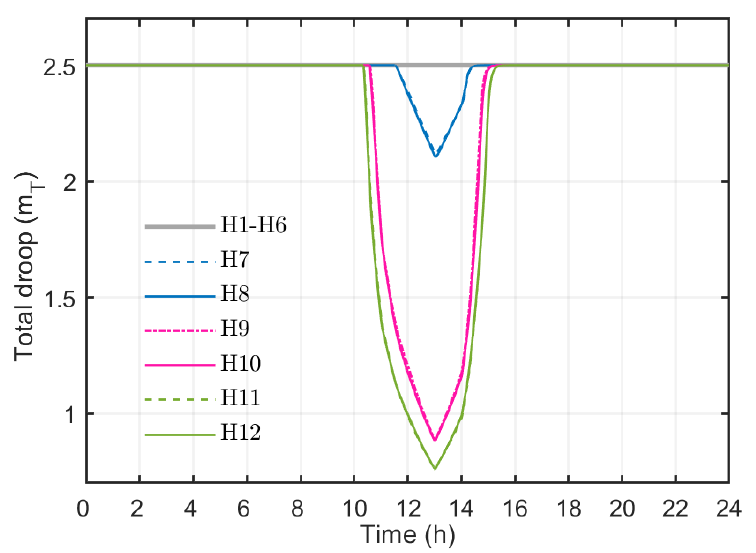
Figure 12. Droop values of twelve houses (House 1 to House 12) in linear droop-based APC method using ADP. Total droop ( m T ) for each house is the sum of constant droop ( m = 2.5 kW/V) and droop adjustment from ADP ( m ADP